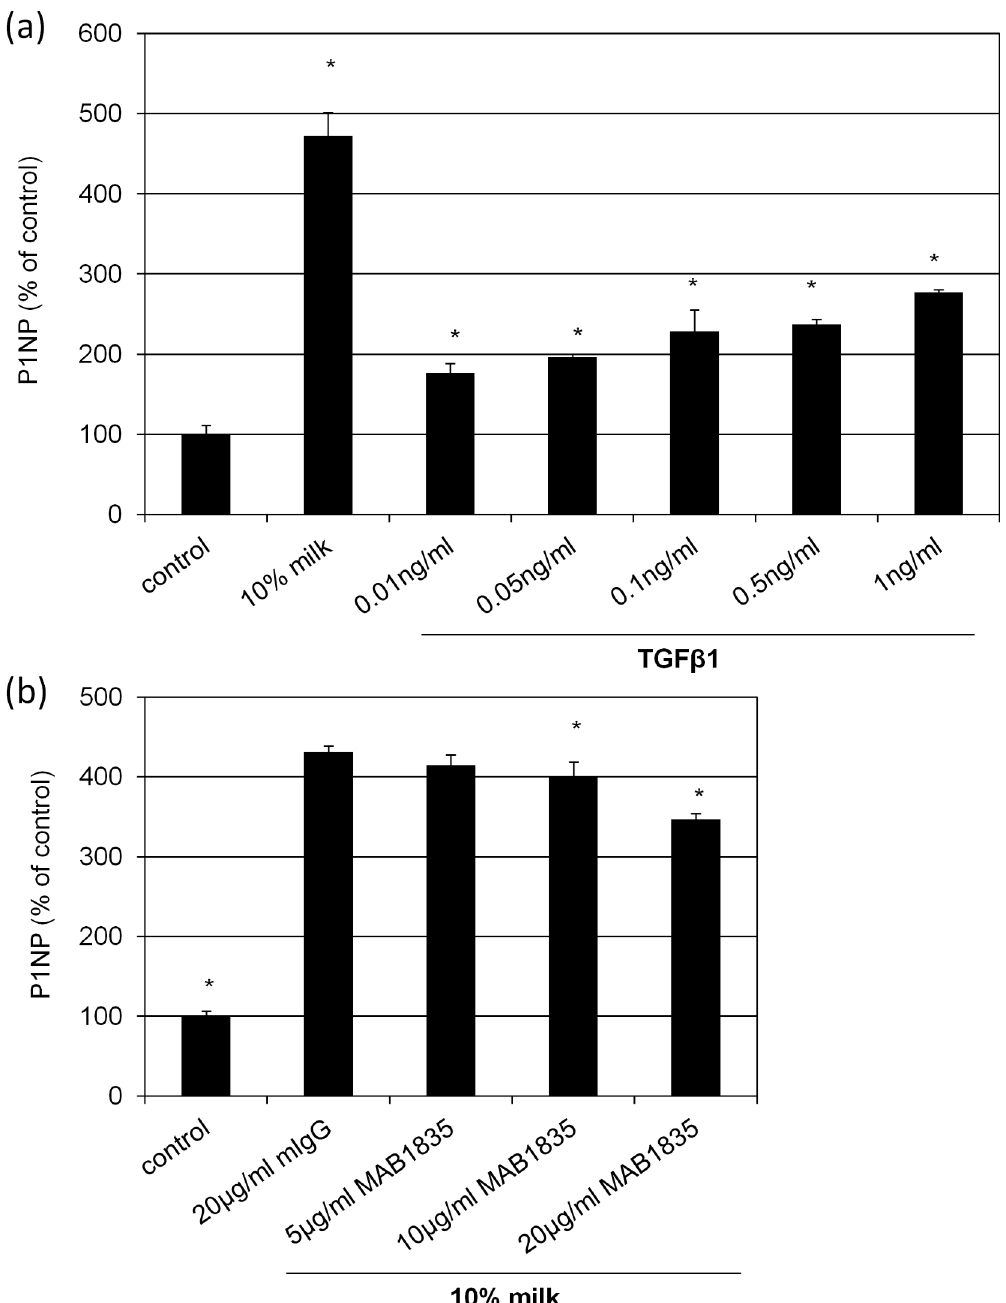
Fig 5. TGF β 1 regulates collagen synthesis. Human skin fibroblasts were treated (a) with 10% bovine milk or with 0.01, 0.05, 0.1, 0.5, 1.0 ng/ml TGF β 1 or (b) with 10% milk containing 5, 10, 20 μ g/ml TGF β 1,2,3 neutralizing antibody MAB1835. Cells held under FCS-free conditions served as control. After 48 h the amount of P1NP in the supernatants was measured. Each bar represents the mean of 3 independent experiments. Standard deviations are indicated. Data of (a) were compared to cells held under FCS-free conditions, and (b) treated with 10% milk and 20 μ g/ml mIgG. * p < 0.05